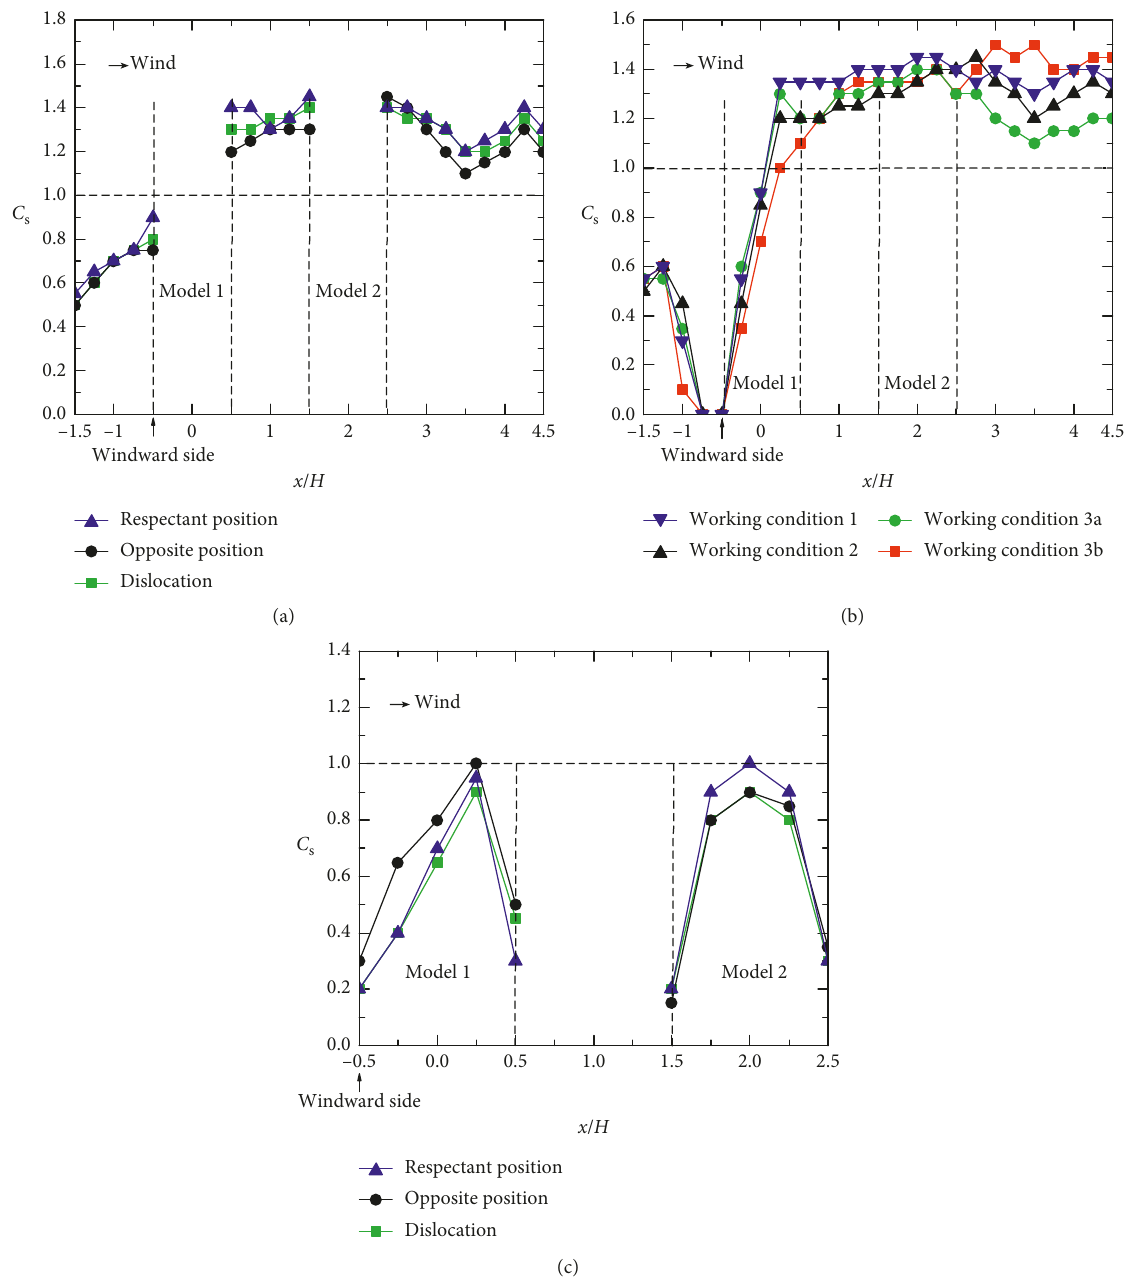
Figure 12: Snow distribution curve at different hole locations of the two models: snow distribution around the (a) central and (b) longitudinal axes as well as (c) surface